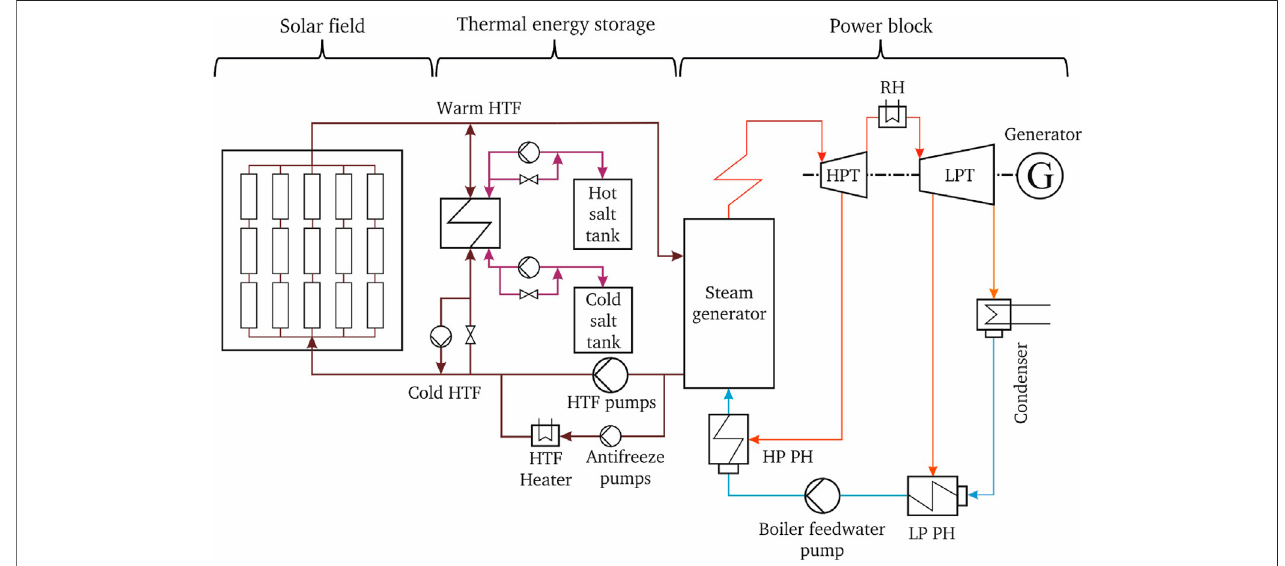
FIGURE 6 | Schematic fl ow diagram of a modern waste incinerator power plant (source Alobaid et al., 2018a).